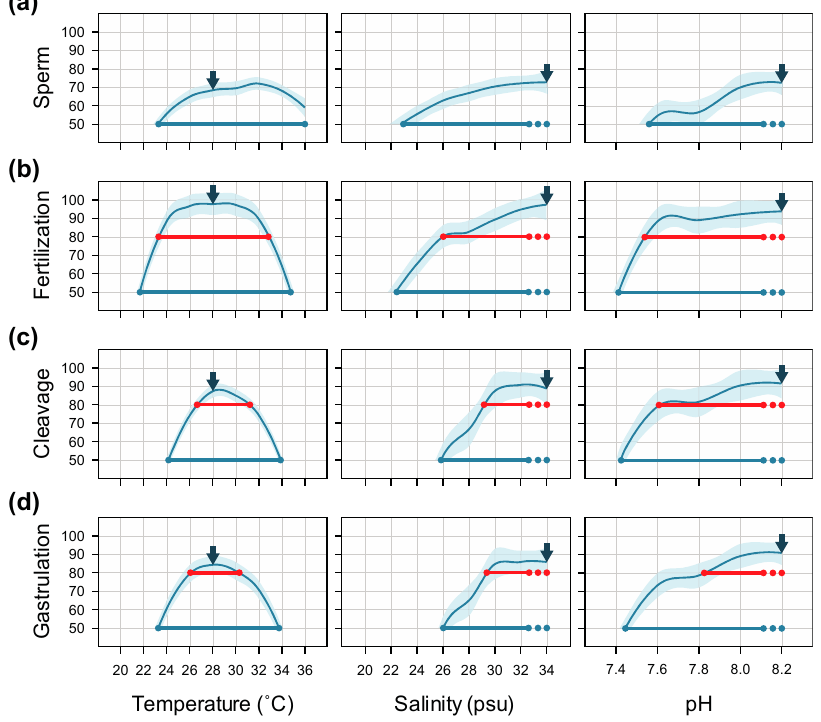
Figure 5. Environmental tipping points for: ( a ) sperm motility; ( b ) fertilization; ( c ) cleavage; and ( d ) gastrulation. Arrows signify mean ambient levels during spawning. Curves are loess smoothers fitted to dataset with proportions >50%; bold lines cover the range where: ( a ) proportion of motile sperm; ( b ) fertilization; ( c ) cleavage; and ( d ) gastrulation rates were >50% (dark blue) or >80% (red). Ellipses indicate that upper limits (above ambient) were not examined.